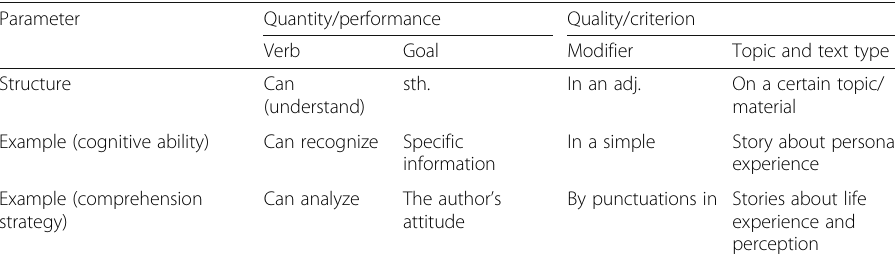
Table 4 Parameters of reading descriptor